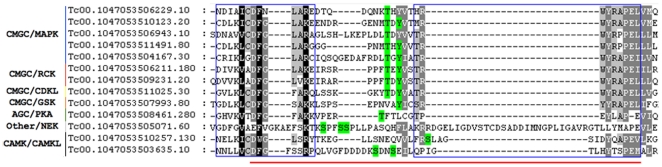
Kinases with phosphorylated activation loop.Blue boxes represent the conserved regions. Red line at the bottom represents the activation region, with the non-organized activation loop in between the two conserved regions. The identified phosphorylation sites are highlighted in green.